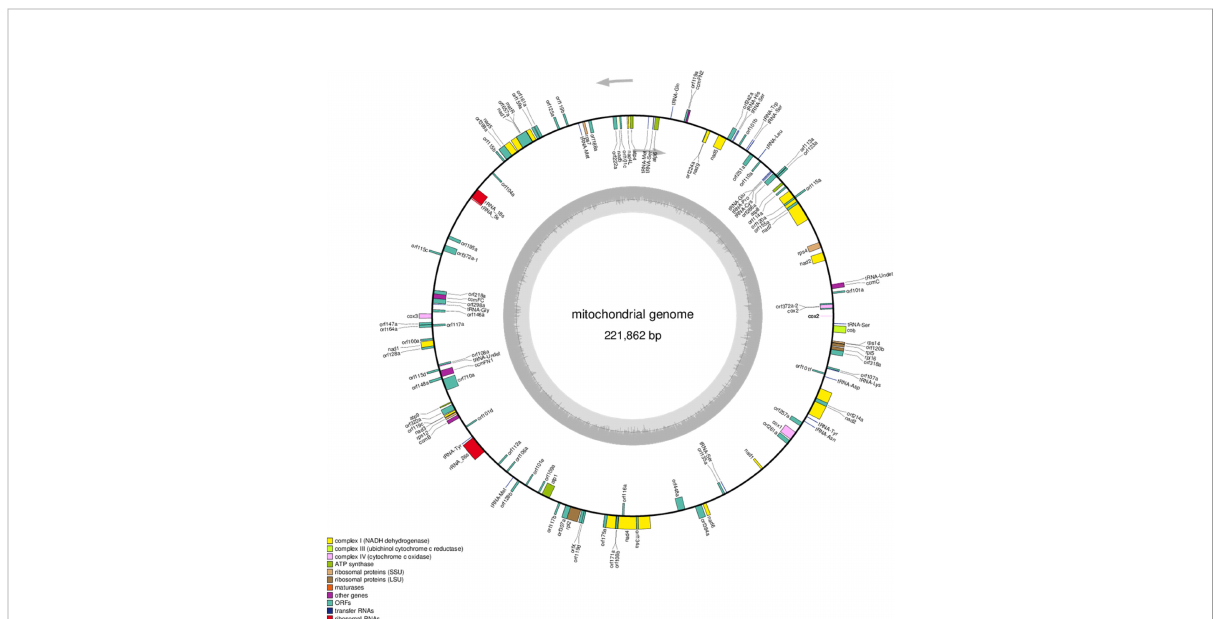
FIGURE 2 Mitochondrial genome map of the C5-type CMS line. Genes with names inside the circle are transcribed clockwise. Genes with names outside the circle are transcribed counterclockwise. The colors of the genes denote the functions of the gene